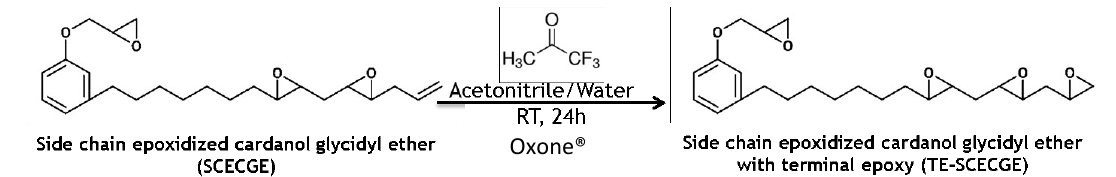
Figure 1. Synthesis scheme of the terminal double bond epoxidation reaction via representative idealized structures.